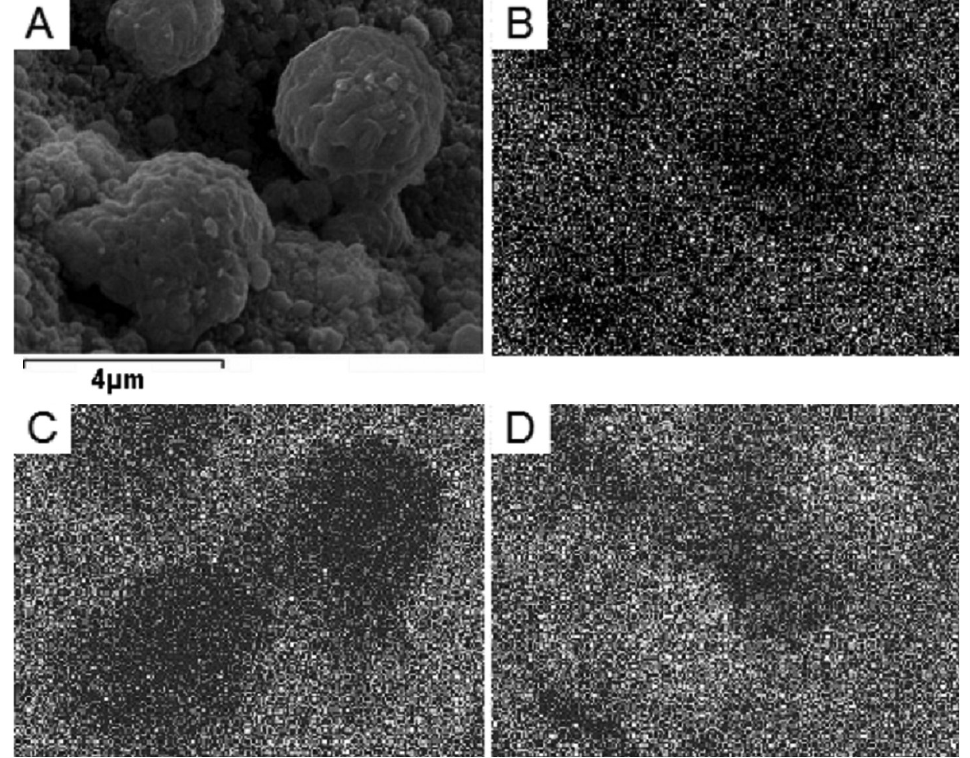
Figure 6. SEM micrograph of agglomerates (A) on NiO/NiAl corresponding EDX analyses. Oxygen (B), aluminium (C), nickel